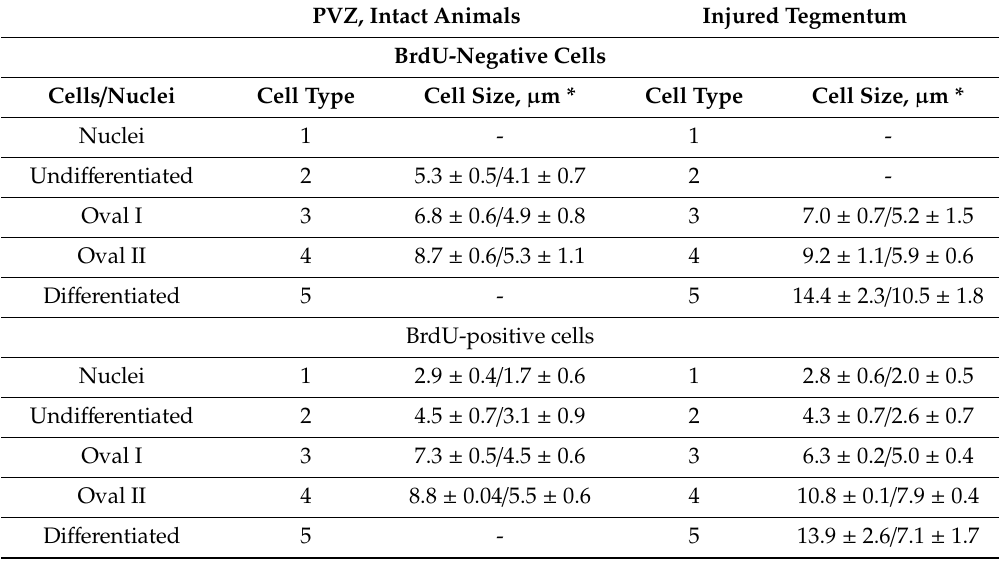
Table 1. Morphometric characteristics of BrdU-labeled cells (M ± SD) in the intact and